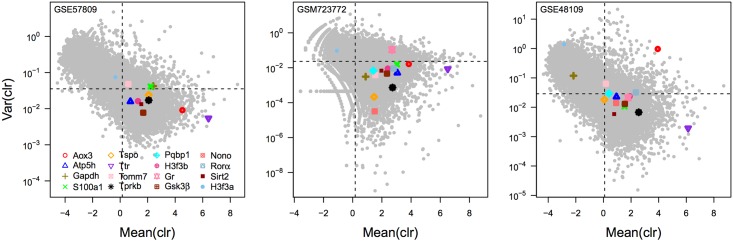
Centered log-ratio analysis of three publicly available RNA-sequencing experiments.We conducted clr analysis on three publicly available RNA-sequencing experiments that compared the liver transcriptome of 3 and 21 month-old mice [GEO: GSE57809], between different mouse tissues [GEO:GSM723772], and the liver transcriptome of male and female mice [GEO:GSE48109]. For each study, the variance and mean across all experimental conditions of the clr of the expression is plotted for each gene. The 16 candidate marker genes are highlighted and the median variance clr and median mean clr across all genes are shown as dashed lines.